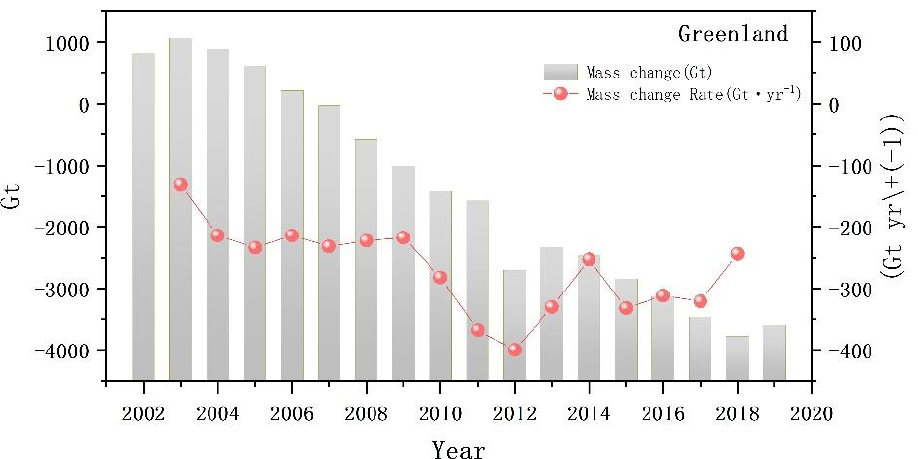
Figure 3. Greenland’s total mass trends from 2002 to 2019 and mass change rate.